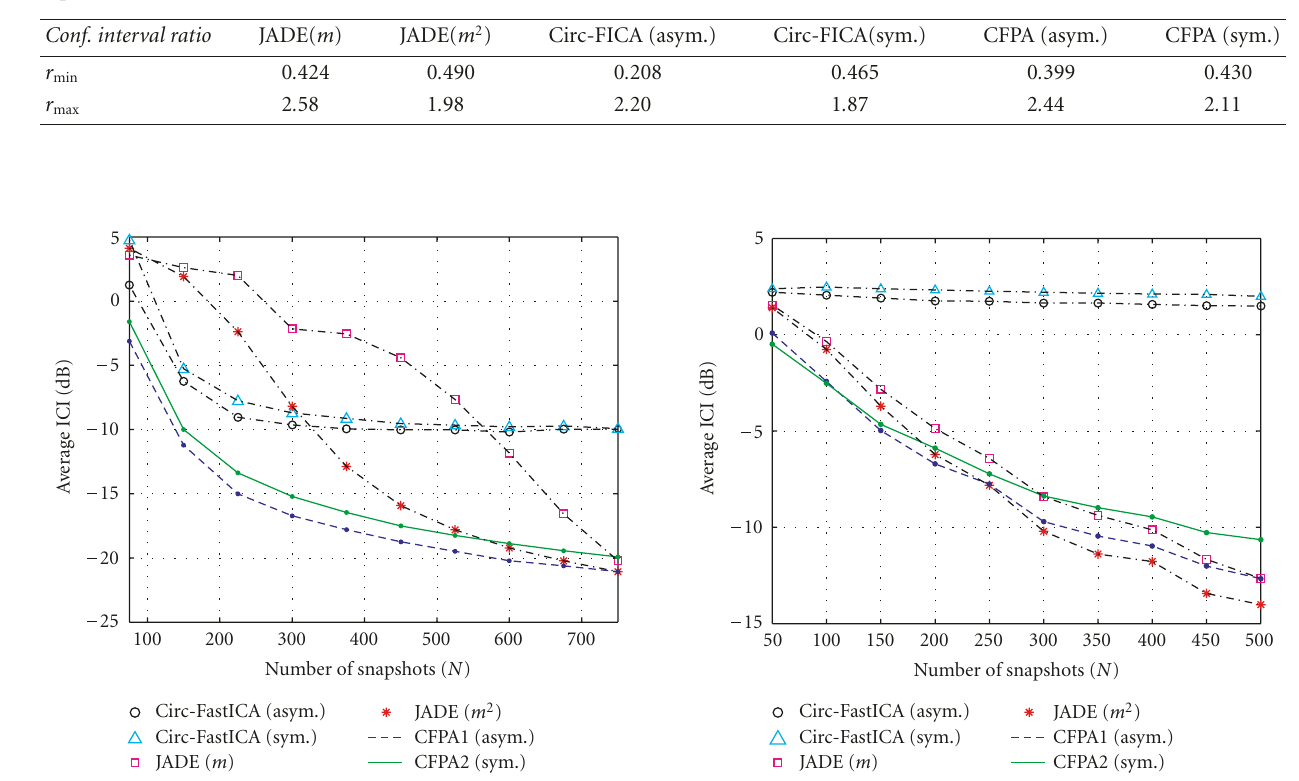
Table 1: Averaged 95% confidence intervals for the various algorithms as a ratio to the average ICI for the various algorithms in the first experiment.